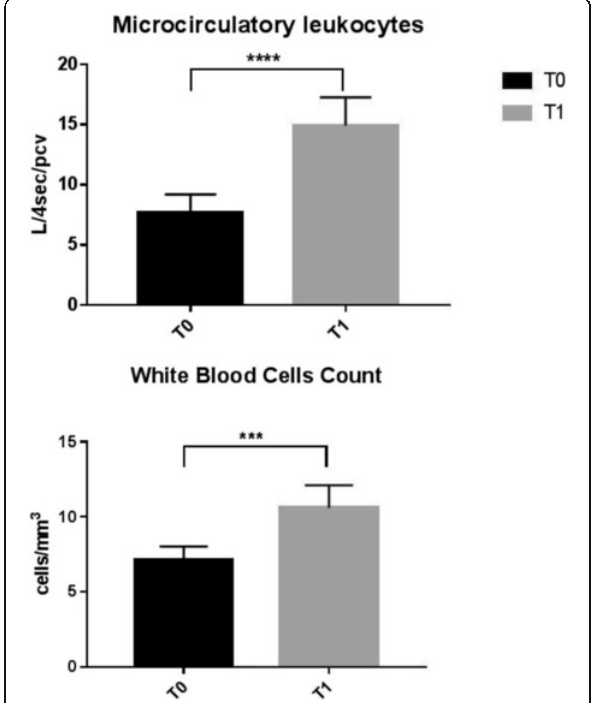
Fig. 18 (abstract A31). Leukocytes count in systemic and